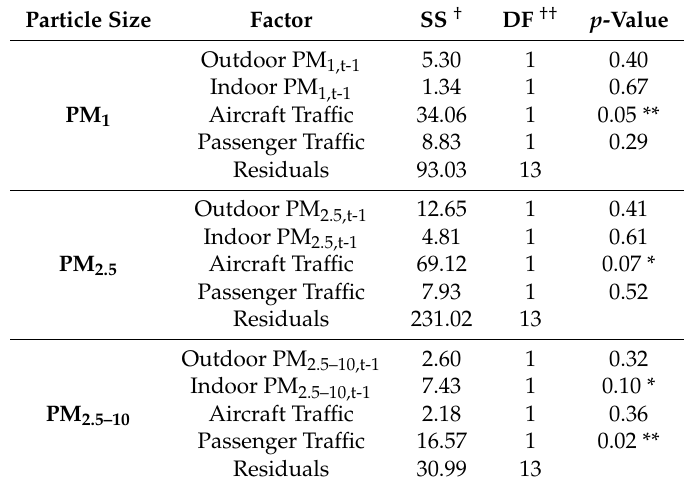
Figure 10. The aircraft and passenger traffic time series of the selected two days. The shaded area shows the period when air quality data were collected at the terminal. Table 6. ANCOVA for the effects of aircraft and passenger traffic on indoor particle